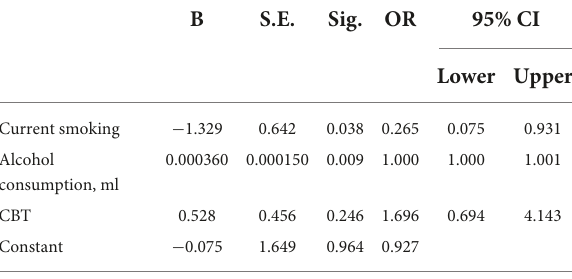
TABLE 4 Statistically significant results in Binary logistic regression models for relapse.